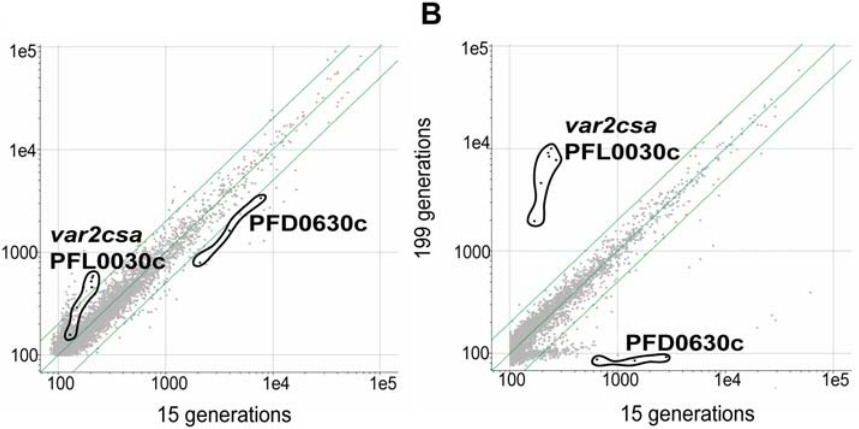
Figure 3. Comparisons of global transcriptomes of 3D7S8.4 as studied by microarray analysis. RNA was obtained from 15 vs. 33 generations and 15 vs. 199 generations. (A) off-switching of the originally dominant var PFD0630c and on-switching of PFL0030c ( var2csa ) was already seen at 33 generations; (B) var2csa (PFL0030c) was highly up-regulated in long-term cultured parasites and almost no PFD0630c was detected (background signal level) at 199